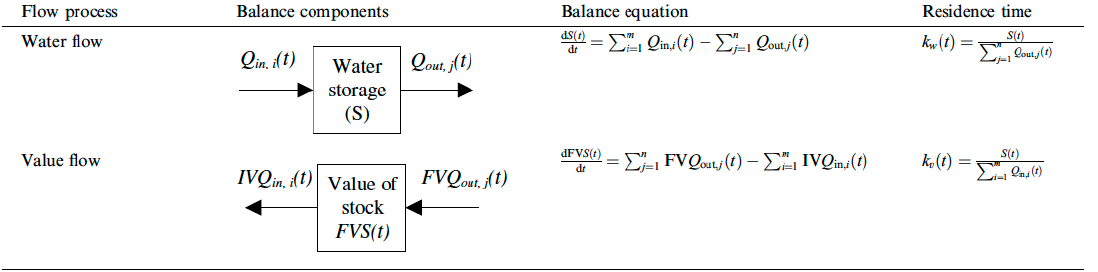
Figure 2. Comparison of water flow and value-flow processes (source: [15]).